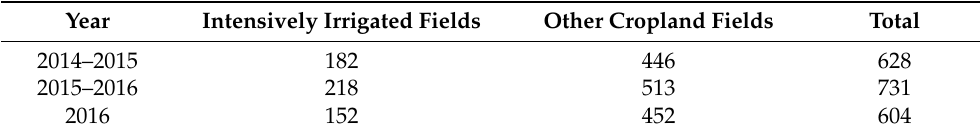
Table 1. The number of intensively irrigated fields (irrigation in summer, kharif, and rabi cropping seasons) and other cropland fields (partially irrigated in the absence of rainfall, non-irrigated, and fallow land) sampled.